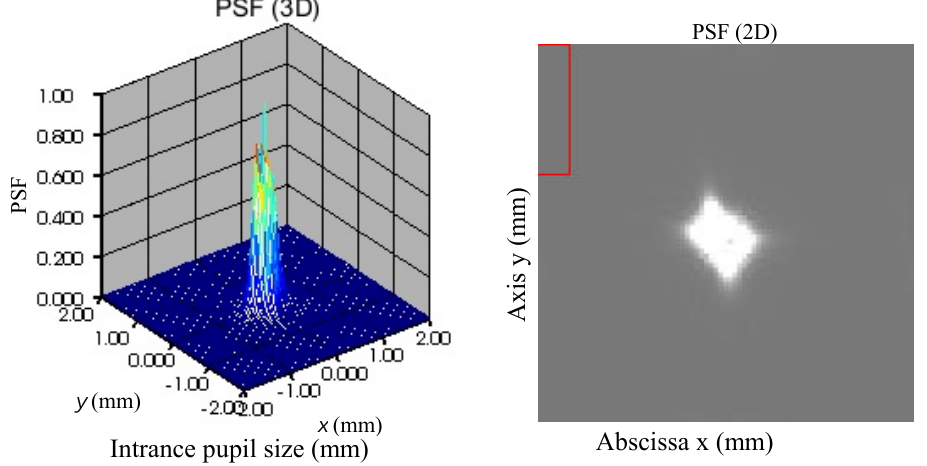
Figure 4. PSF of the distorted wavefront.